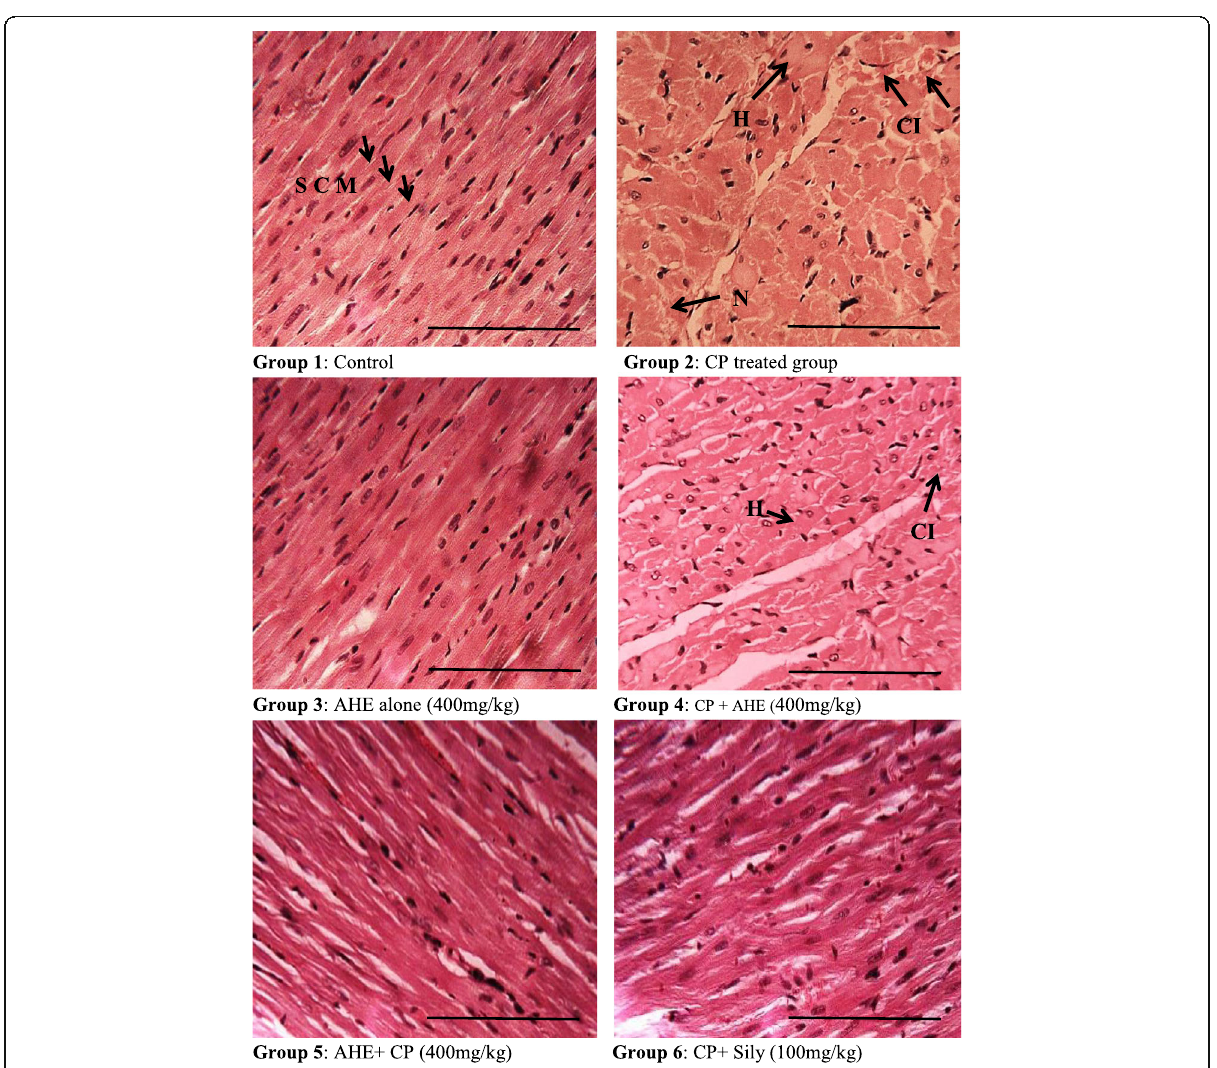
Fig. 2 Histopathological effect of Cisplatin and protective effect of AHE in rat heart (H&E staining, magnification 40X). Group 1: Cardiac section from control rats showing normal morphology. Group 2: cardiac sections from CP-treated rats reveal degenerative changes. Group 3: Represents cardiac section from AHE alone treated rats. Group 4: AHE Post-treatment showed reduced degenerations. Group 5: AHE Pre-treatment results in significant protection against CP induced renal injury. Group 6: Showed protective effect of Silymarin treatment. AHE- A.hydaspica ethyl acetate fraction, CP-Cisplatin, SCM-striated cardiac muscles, H-hypertrophy, N-necrosis, CI-cellular infiltrations. Scale bar represent 100 μ